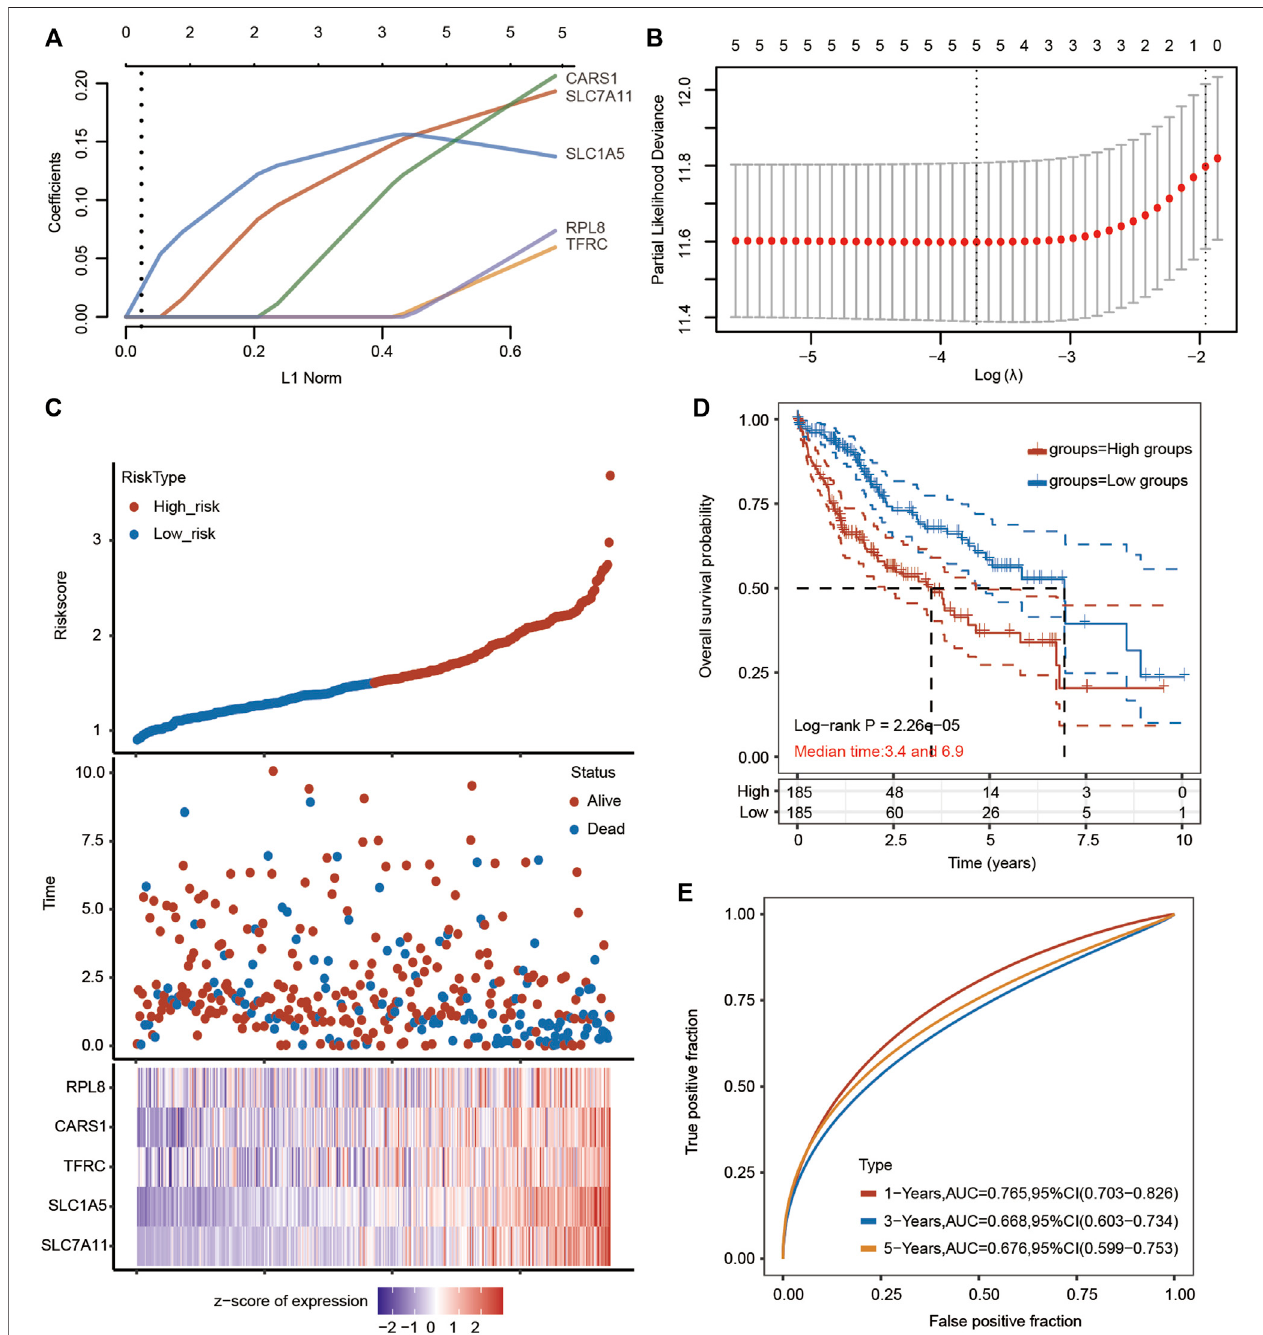
FIGURE 8 | Prognostic analysis of the fi ve-FRG signature model in the TCGA-HCC cohort. (A,B) LASSO Cox regression analysis was performed to build a prognosticmodel basedon5FRGs. (C) Thedistributionsoftheriskscoreand OSstatusintheTCGA-HCC cohort. (D) Kaplan – Meiercurves fortheOSofHCC patients in the low-risk group and high-risk group in the TCGA-HCC cohort ( p < 0.001, Log-rank test). (E) The AUC of time-dependent ROC curves veri fi ed the prognostic performance of the risk score in the TCGA-HCC cohort.